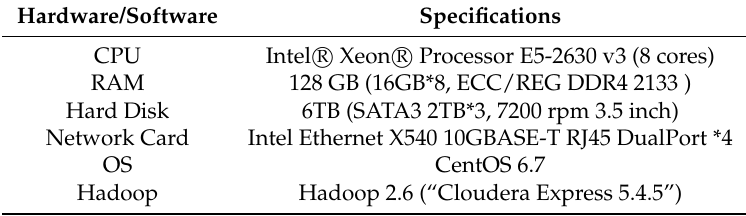
Table 5. Specifications of hardware and software within one computing node.